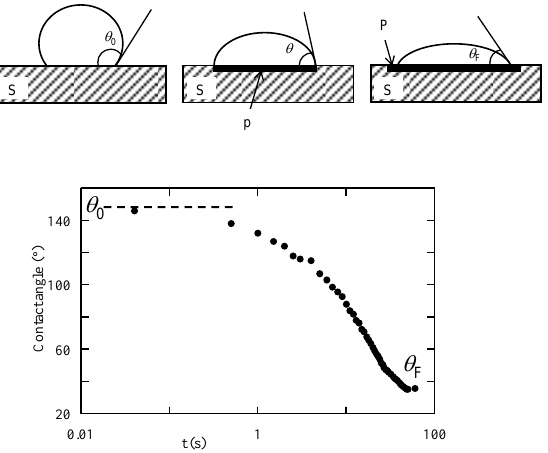
Figure 6. Top : Schematic representation of the “Reaction Product Control” model [2]. The initial contact angle θ 0 is the contact angle on the surface of the unreacted ceramic substrate S. After a transient stage, a quasi-state configuration is established at the triple line where the advance of the liquid is hindered by the presence of a non-wettable substrate in front of the triple line. Thus, the only way to move ahead is by lateral growth of the wettable reaction product layer P until the macroscopic contact angle equals the equilibrium contact angle θ F of the liquid on the reaction product. Bottom : Contact angle vs . logt for Si on vitreous carbon (where P = SiC) according to [16].